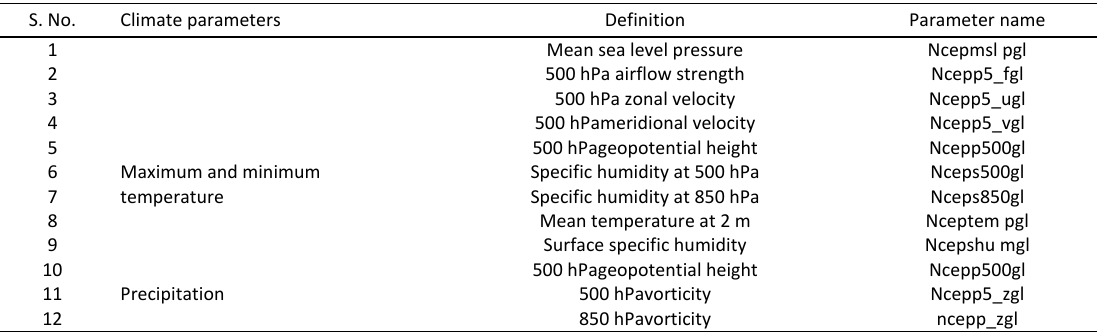
Table 2: List of predictor variable used for statistical downscaling of minimum, maximum temperature and precipitation S. No.